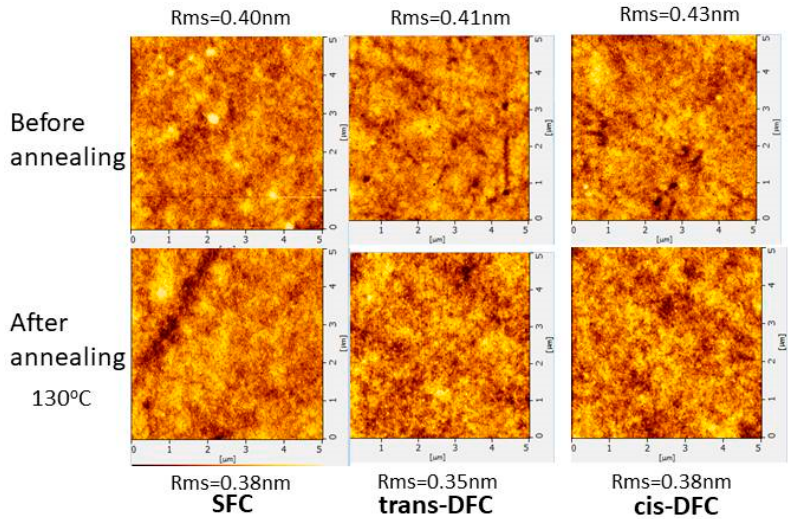
Figure 2. AFM images of SFC, trans -DFC and cis -DFC on indium tin oxide (ITO) at room temperature ( up ) and after annealing at 130 °C for 30 min ( down ).